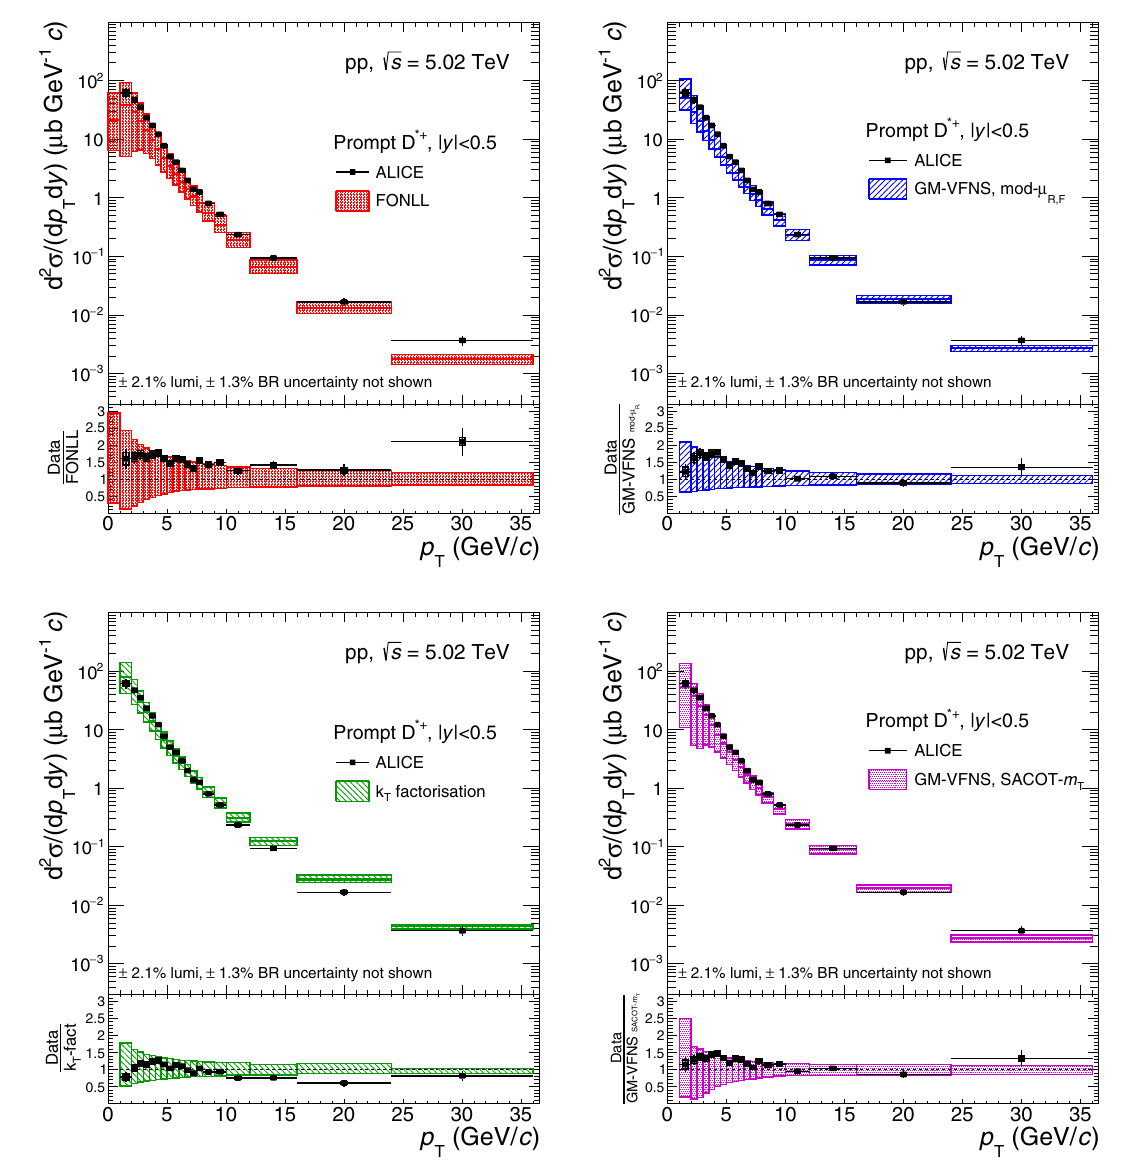
D ∗+ and D + mesons. The systematic uncertainties on the calculations, which describe consistently the increasing trend s measured ratios were obtained treating the contribution orig- as a function of p T observed in the data. In the FONLL pre- dictions, the uncertainties originating from scale variations inating from the subtraction of the feed-down from beauty- and from PDFs cancel out to a large extent in the ratio [24], hadron decays as correlated, while all the other systematic thus making the magnitude of the theoretical uncertainties uncertainties on the cross sections were propagated as uncor- comparable with those of the related between the measurements at the two different ener- gies, except for the uncertainty on the BR, which cancels out are com- in the ratio. The results for D 0 , D + , D ∗+ and D + s pared in Fig. 14, on the left panel. The ratios for the different D-meson species are compatible within uncertainties. In the right panel, the D 0 -meson results are compared to FONLL